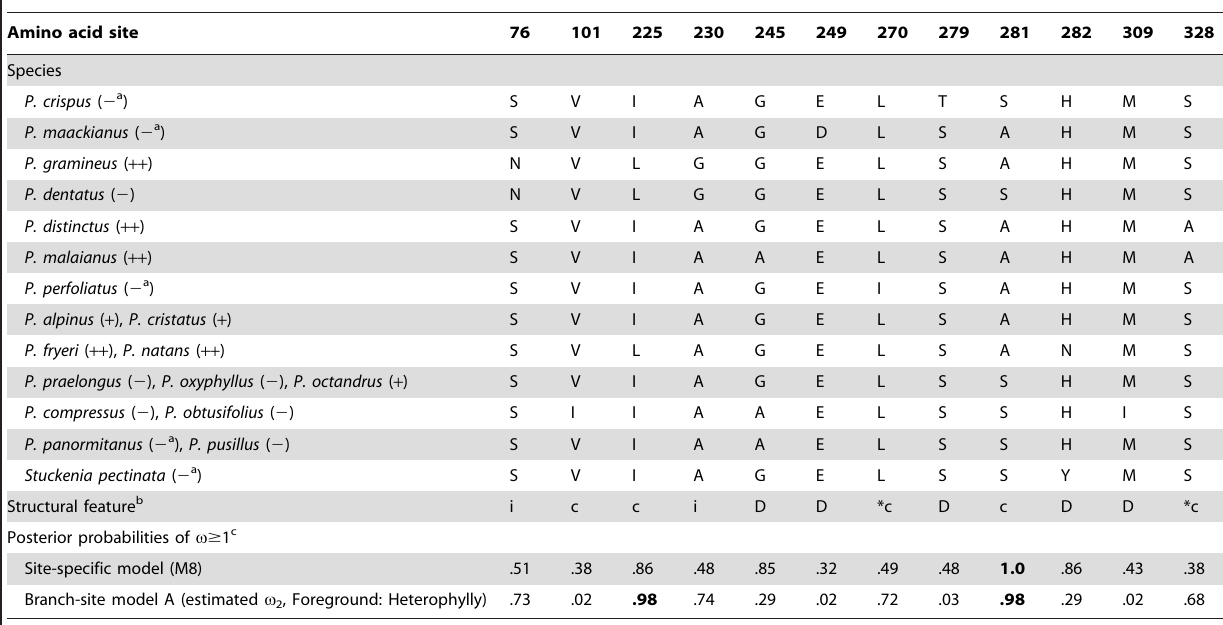
Number corresponds to the amino acid position of spinach RbcL. ( 2 ): homophyllous plant with submerged leaves, ( + ): heterophyllous plant with submerged and floating leaves, ( ++ ): heterophyllous plant with submerged, floating and terrestrial leaves. a the species is also distributed in brackish water. b *: residues that are close to the active sites, c: residues that are buried in the interior of RbcL, D: residues at the intradimer interface of RbcL, i: residues at the interface between RbcL and RbcS. c probabilities above 0.95 are indicated in